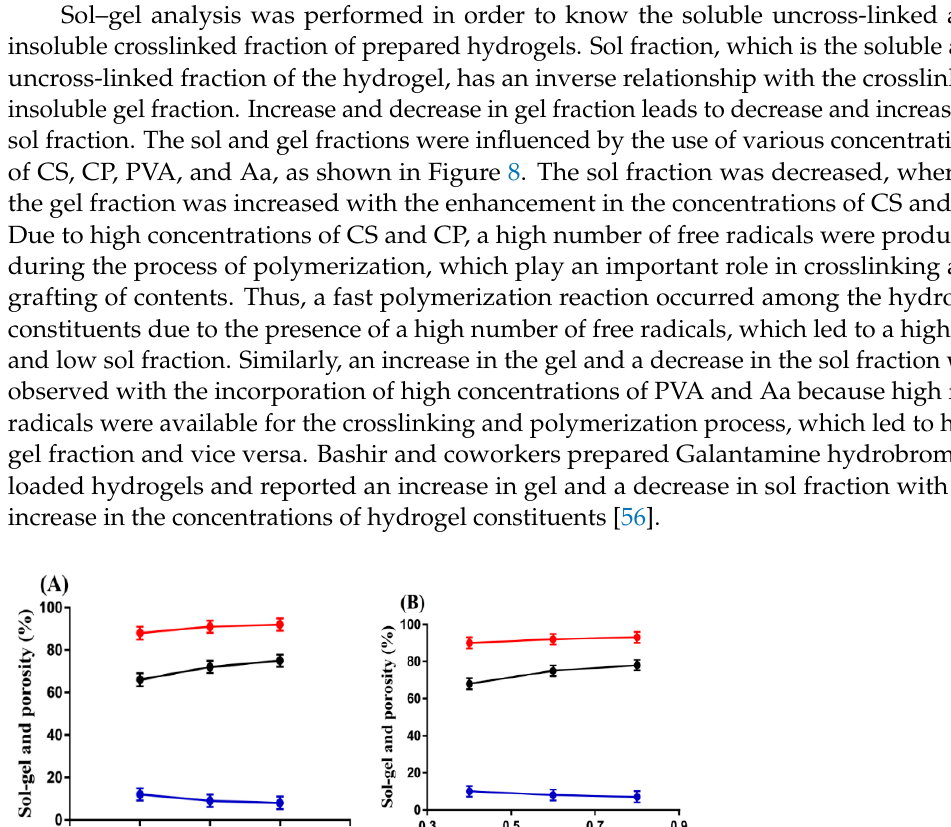
Figure 7. SEM of CS/CP/PVAcPAa hydrogel at different magnifications.